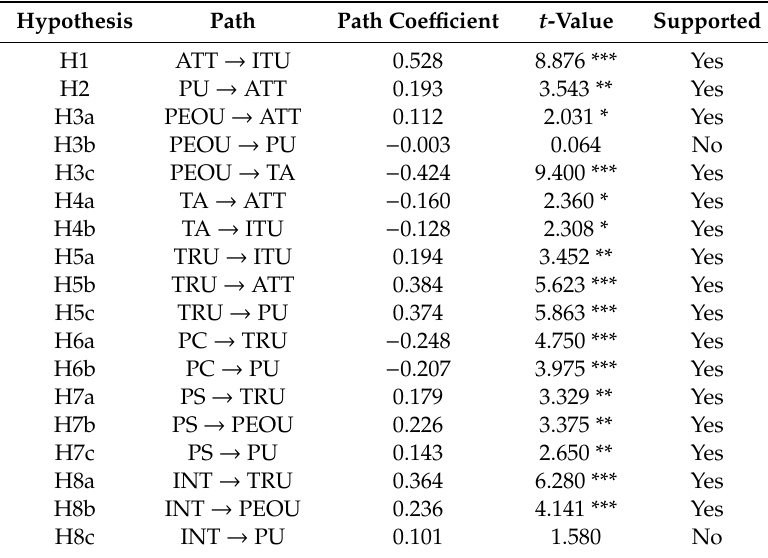
Table 5. Results of hypothesis